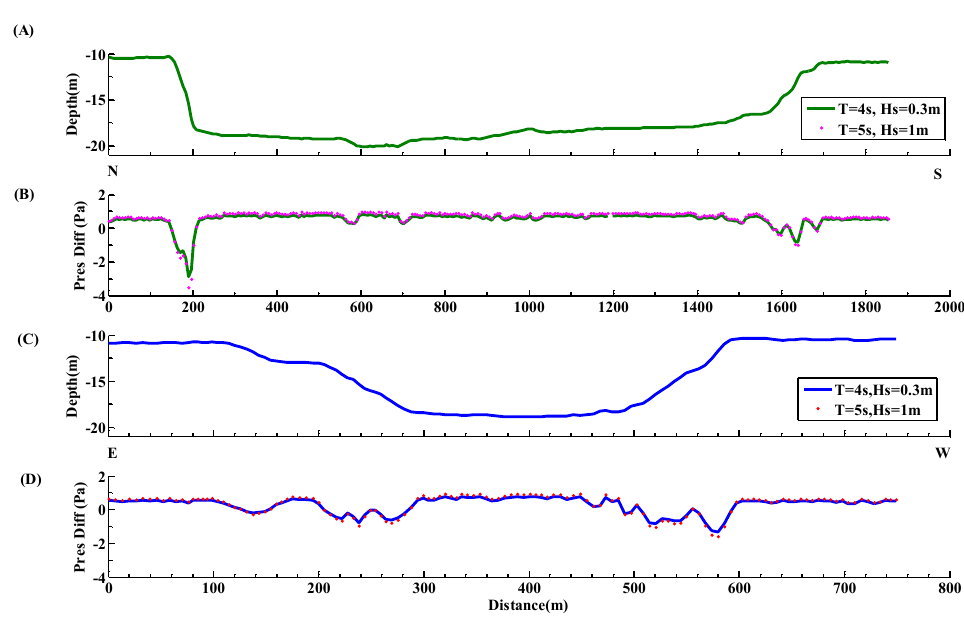
Figure 8. Wave-induced pressure difference around the pit. ( A ) North-South bathymetric profile of the pit; ( B ) pressure difference along the North-South profile; ( C ) East-West bathymetric profile of the pit; ( D ) pressure difference along the East-West profile. See Figure 5B for profile locations.